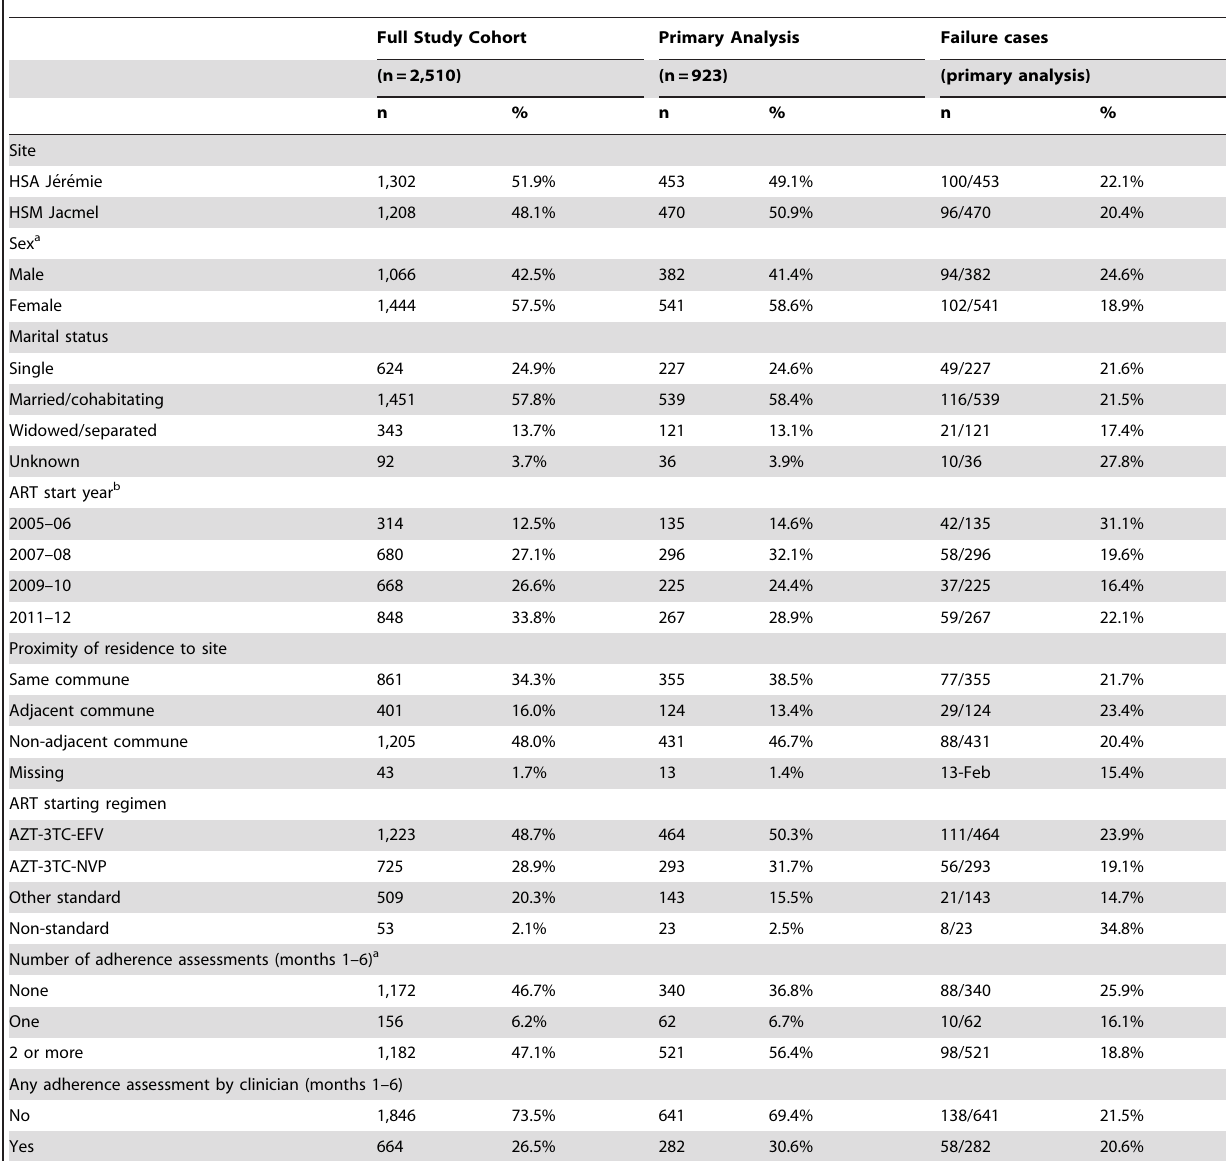
Table 1. Patient Characteristics (Categorical